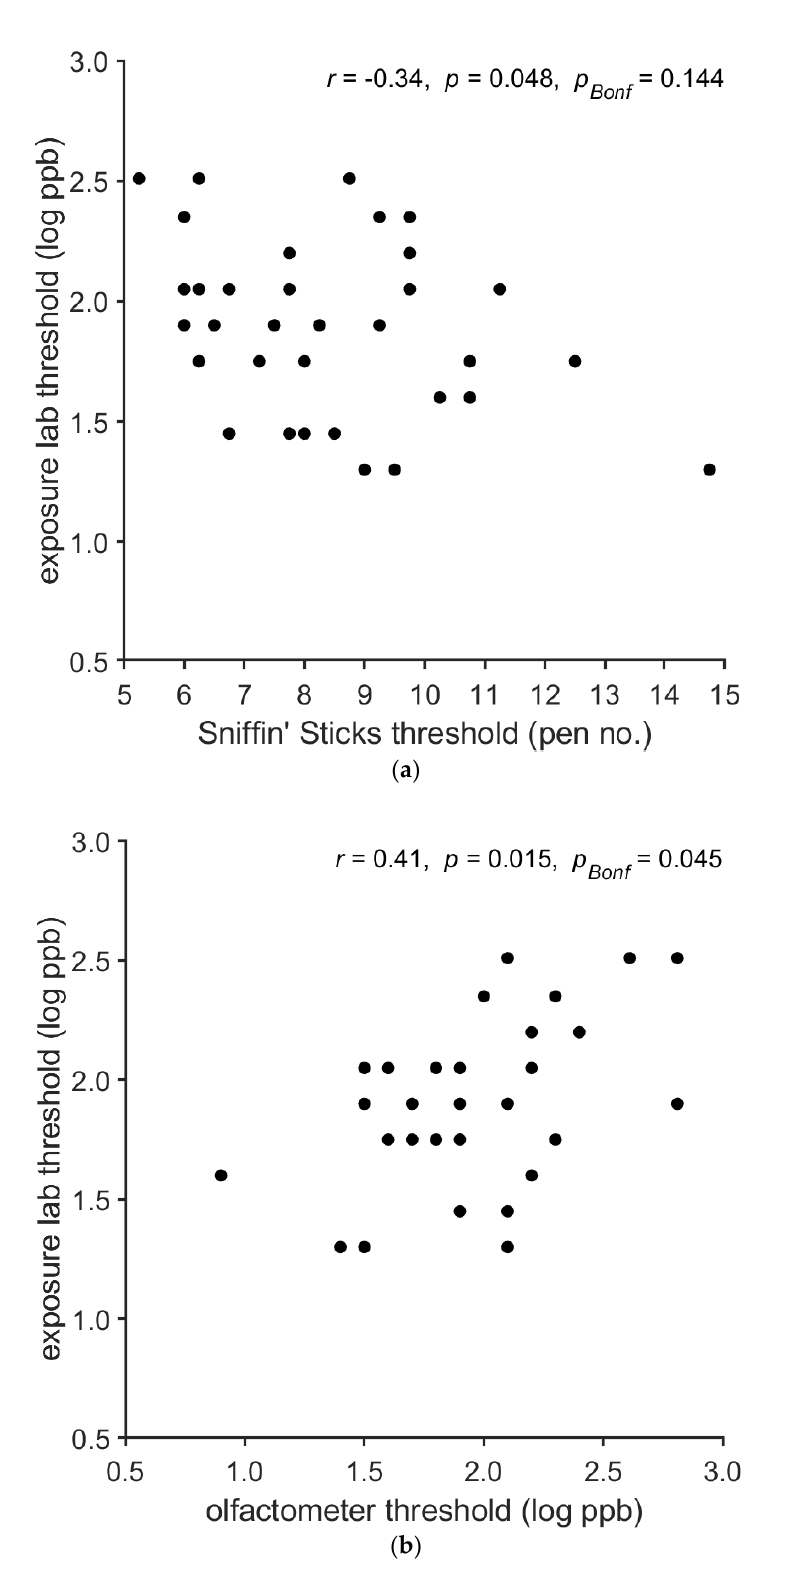
Figure 3. Scatter plots depicting the associations between the n-butanol thresholds derived with the exposure lab and the investigated methods, ( a ) Sniffin’ Sticks and ( b ) olfactometer. Note that in the Sniffin ’ Sticks test, a higher pen number corresponds to a higher n-butanol dilution and thus a lower threshold (higher sensitivity).